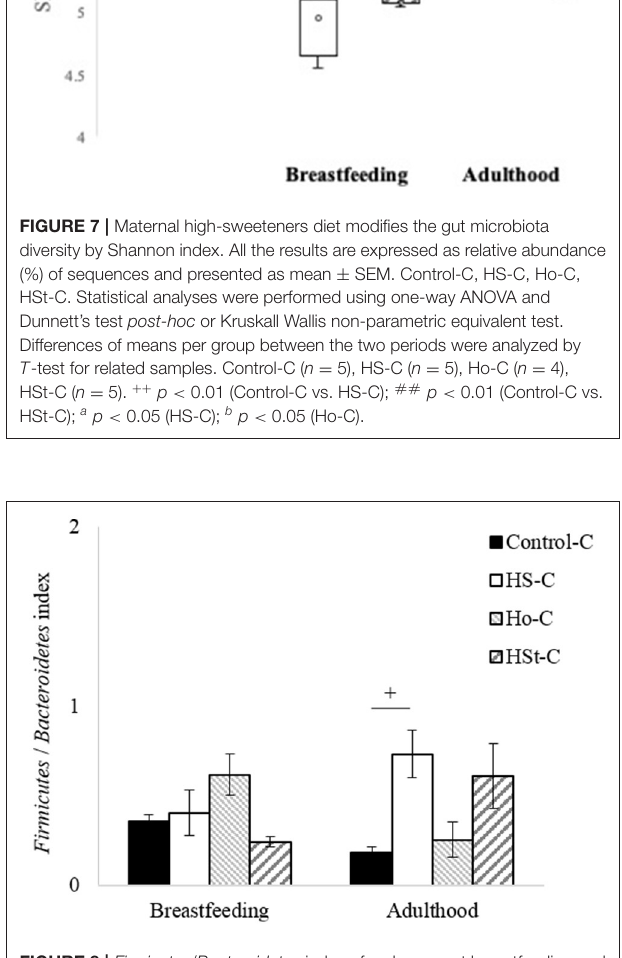
and Bacteroidetes phyla were in adulthood regardless of body weight